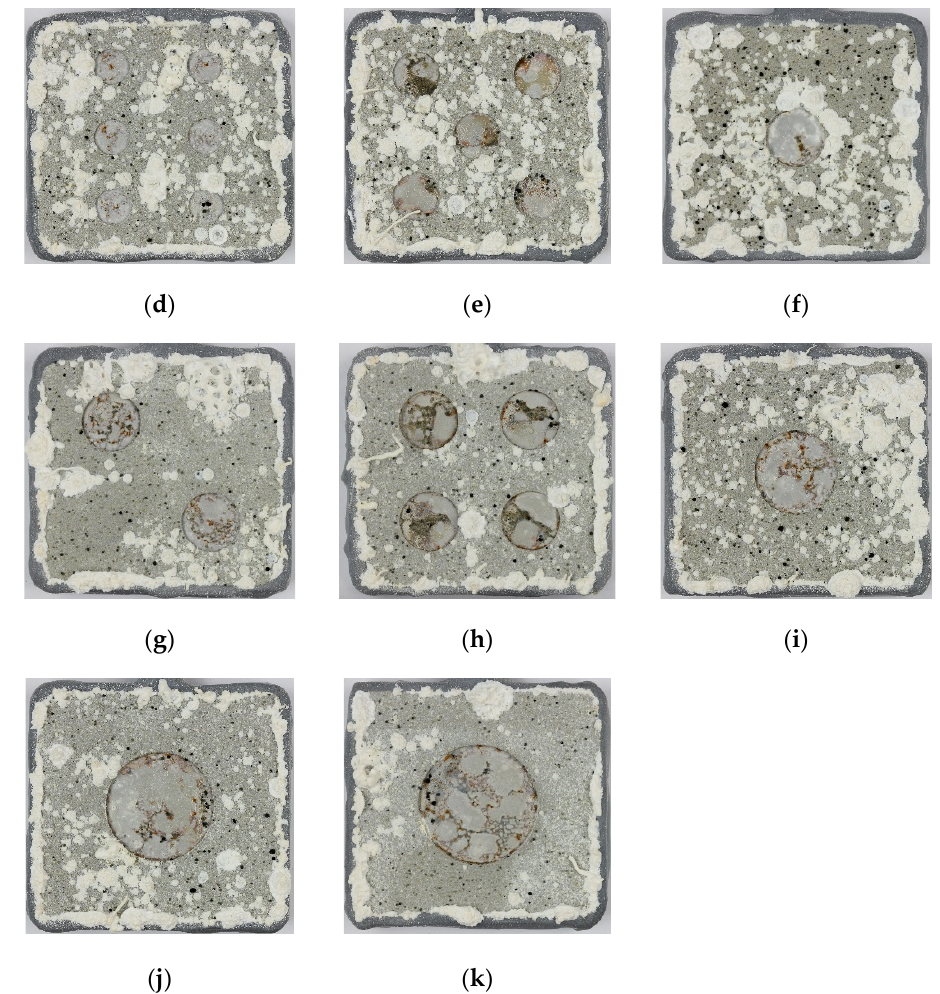
Figure 2. Photographs of specimens after testing for 420 days in ASTM D1141 seawater. The number of holidays/total damage area % was: ( a ) 12/13.7%, ( b ) 4/4.6%, ( c ) 8/9.1%, ( d ) 6/9.9%, ( e ) 5/14.6%, ( f ) 1/4.6%, ( g ) 2/9.1%, ( h ) 4/18.3%, ( i ) 1/8.9%, ( j ) 1/14.8% and ( k ) 1/18.3%. The specimens are 43 mm × 40